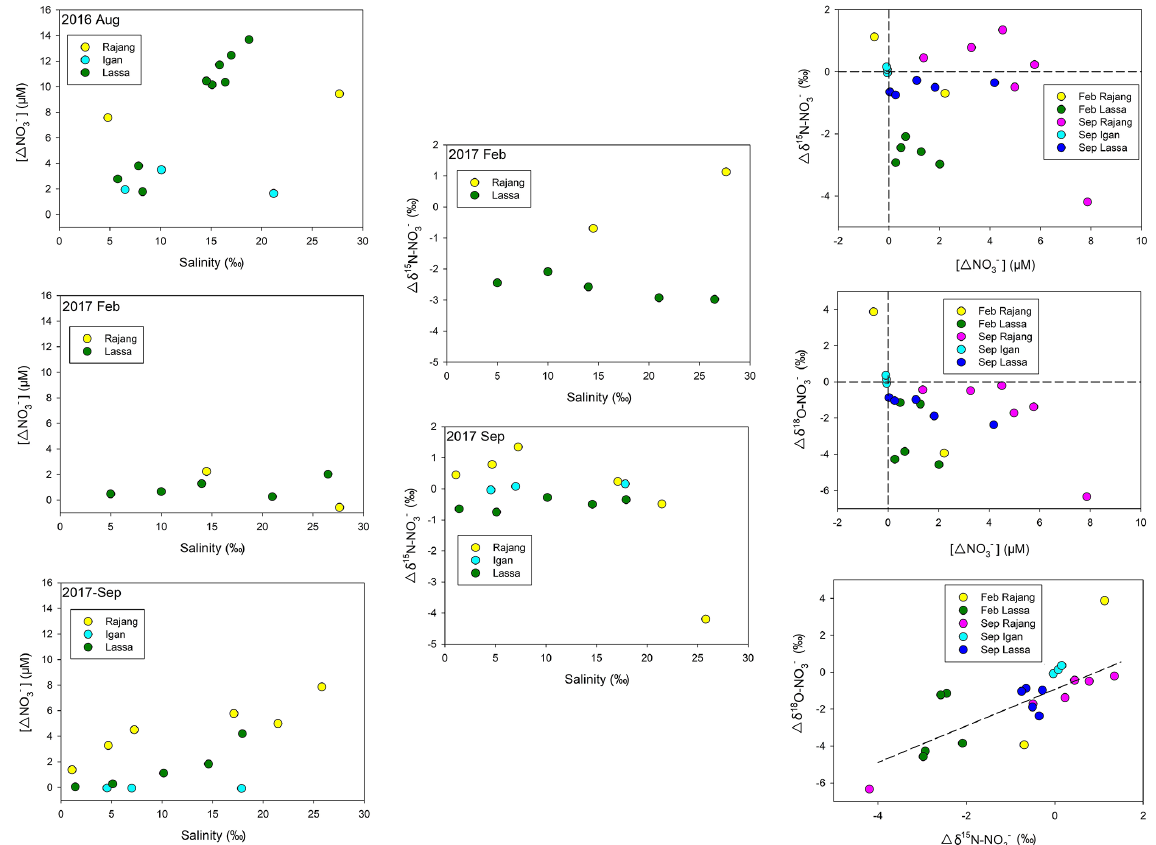
] in the figure) in three Rajang tributaries (Igan, Lassa and Rajang) along concentration offset ([ (cid:49) NO − 3 3 offset ( (cid:49)δ 15 N–NO − in the figure) in three Rajang tributaries along 3 3 offset and the NO − concentration offset for the cruises in 2017; 3 3 and the 18 O–NO − offset, the slope of the correlation curve between δ 15 N–NO − and δ 18 O–NO − being 3 3 3 3